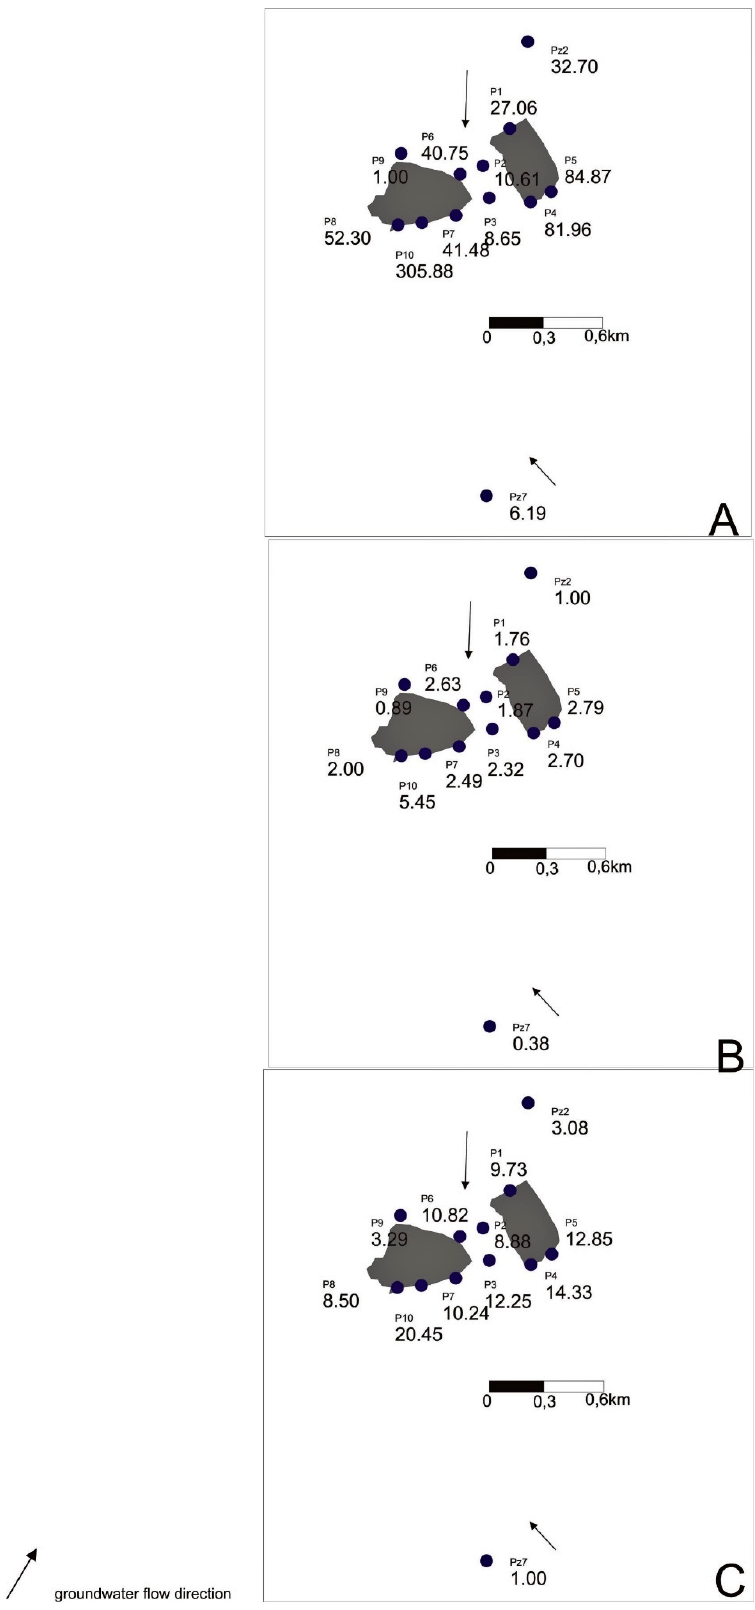
Figure 5. Values of the LWPI index using the results from different piezometers as hydrochemical background: ( A ) P9, ( B ) Pz2, ( C )